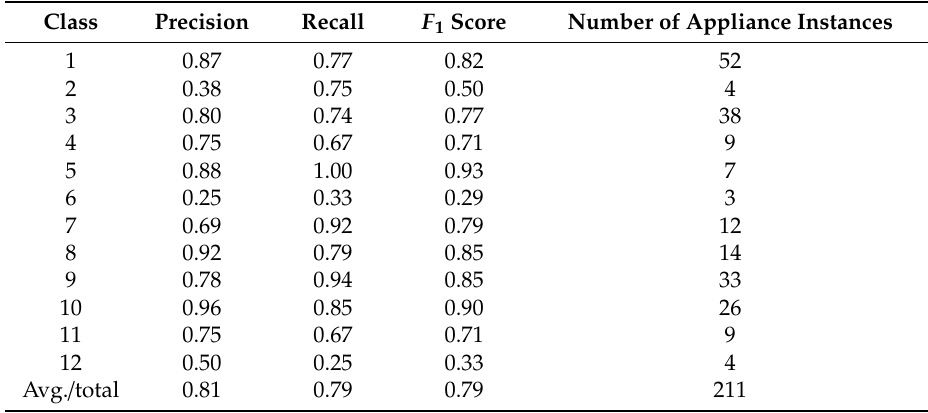
Figure 9. Training trajectory of the feed-forward, multilayer (1-15-12) ANN. Table 5. Load recognition results obtained by the feed-forward ANN where it has been well trained and validated on the class-imbalanced training data.